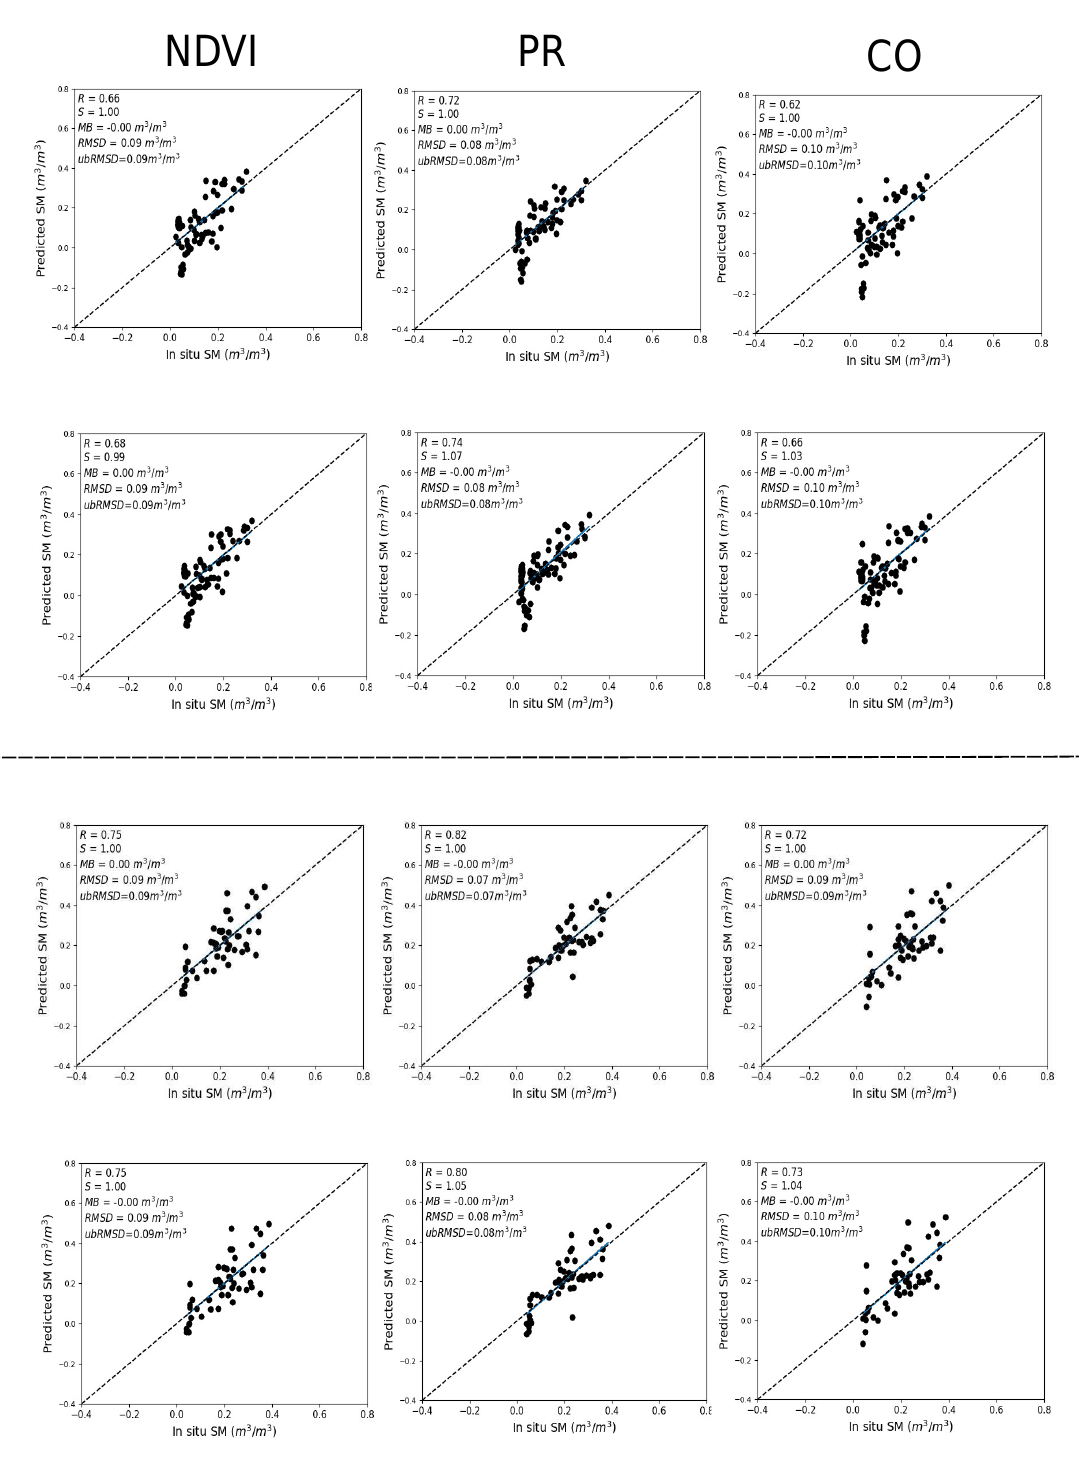
Figure 4. Scatter plot over Chichaoua ( top ) and Sidi Rahal ( bottom ) of predicted versus in situ SM, for linear and non-linear RTM with NDVI, PR and CO as vegetation descriptors separately where in situ SM data are used for